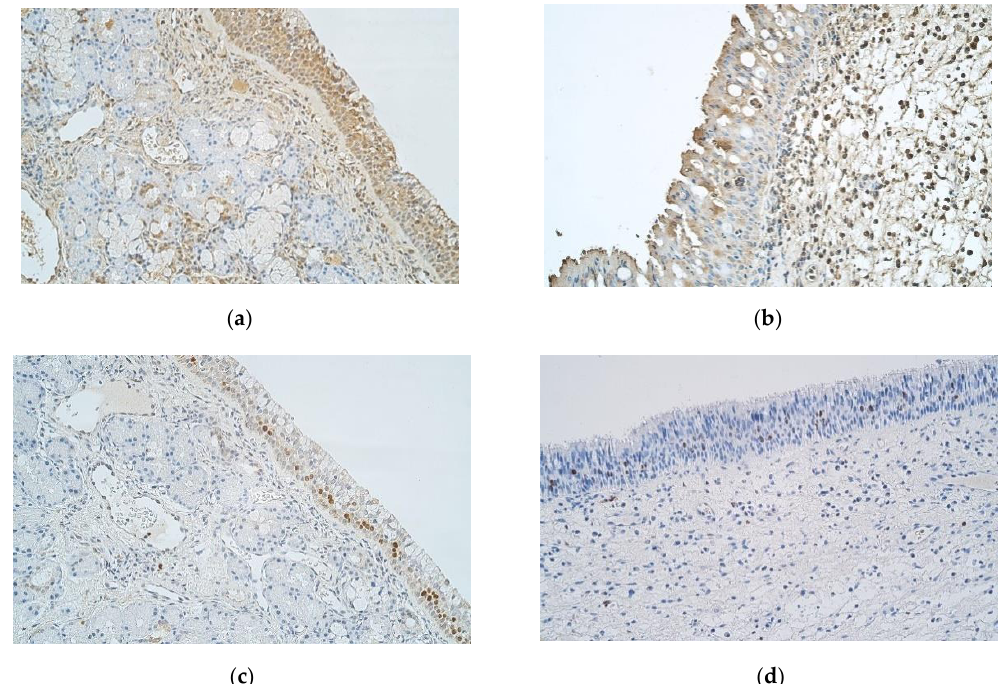
Figure 5. ( a – d ) Immunohistochemical micrographs of inpatients with nasal polyps and control subjects. ( a ) 42-year-old male with healthy nasal mucosa. Numerous IL-12 positive structures in the epithelium of the control sample, but few positive structures in the connective tissue. IL-12 IMH, X 250. ( b ) 30-year-old female with CRSwNP. Few IL-12 positive structures in epithelium and numerous positive structures in the connective tissue of a nasal polyp. IL-12 IMH, X 250. ( c ) 42-year-old male with healthy nasal mucosa. Few to moderate number of Ki67 positive structures in the epithelium and occasional positive structures in connective tissue of the control sample. Ki67 IMH, X 250. ( d ) 33-year-old male with CRSwNP. Few Ki67 positive structures in epithelium and connective tissue of a nasal polyp. Ki67 IMH, X 250.